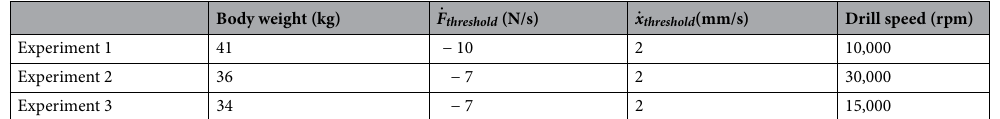
˙ F threshold (N/s) ˙ x threshold (mm/s) Drill speed (rpm)